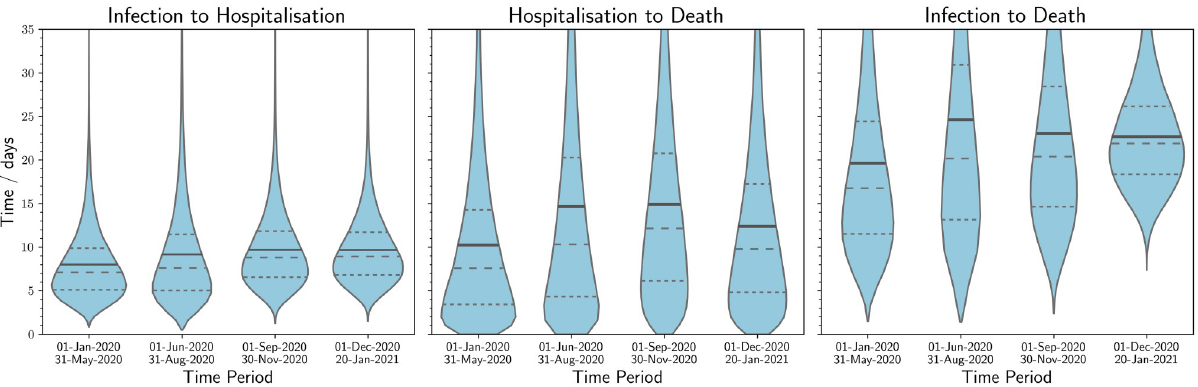
Fig 2. Violin plots of the best fit modelled distributions of times to clinical outcome over the course of the pandemic for category A. The quartiles for each distribution are shown as dashed lines and the solid line corresponds to the mean. In this chart, the data are segmented in time by the former of the two events: symptom onset date for both infection to hospitalisation and infection to death, and hospitalisation date for hospitalisation to death. For the last time period (1 December 2020 to 20 January 2021), the right truncation equation was used. The mean time from infection to hospitalisation has remained relatively stable. For both hospitalisation to death and infection to death, the mean time was lowest in the first wave, and there was a marked increase over the summer months.